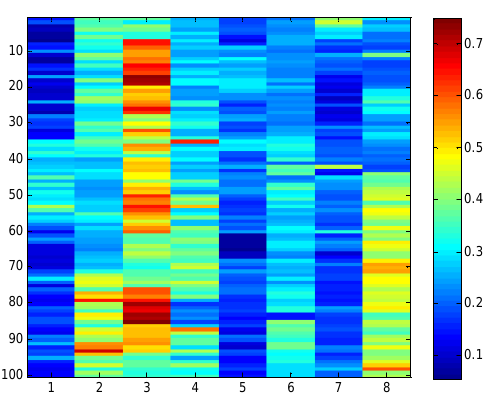
Figure 13. HOG correlation for each sample (1: agricultural, 2: airplane, 3: beach, 4: buildings, 5: chaparral, 6: dense residential, 7: forest, 8: harbor)